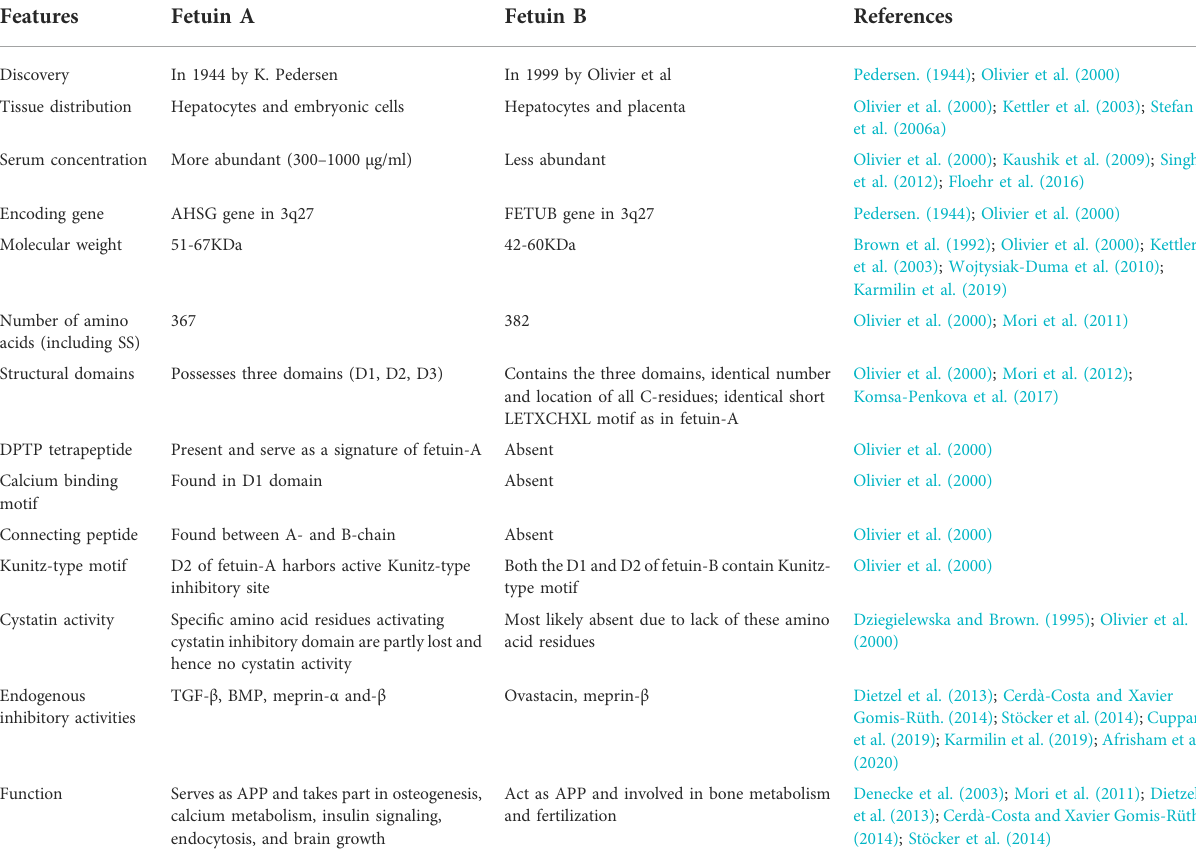
TABLE 1 Comparisons between human fetuin-A and